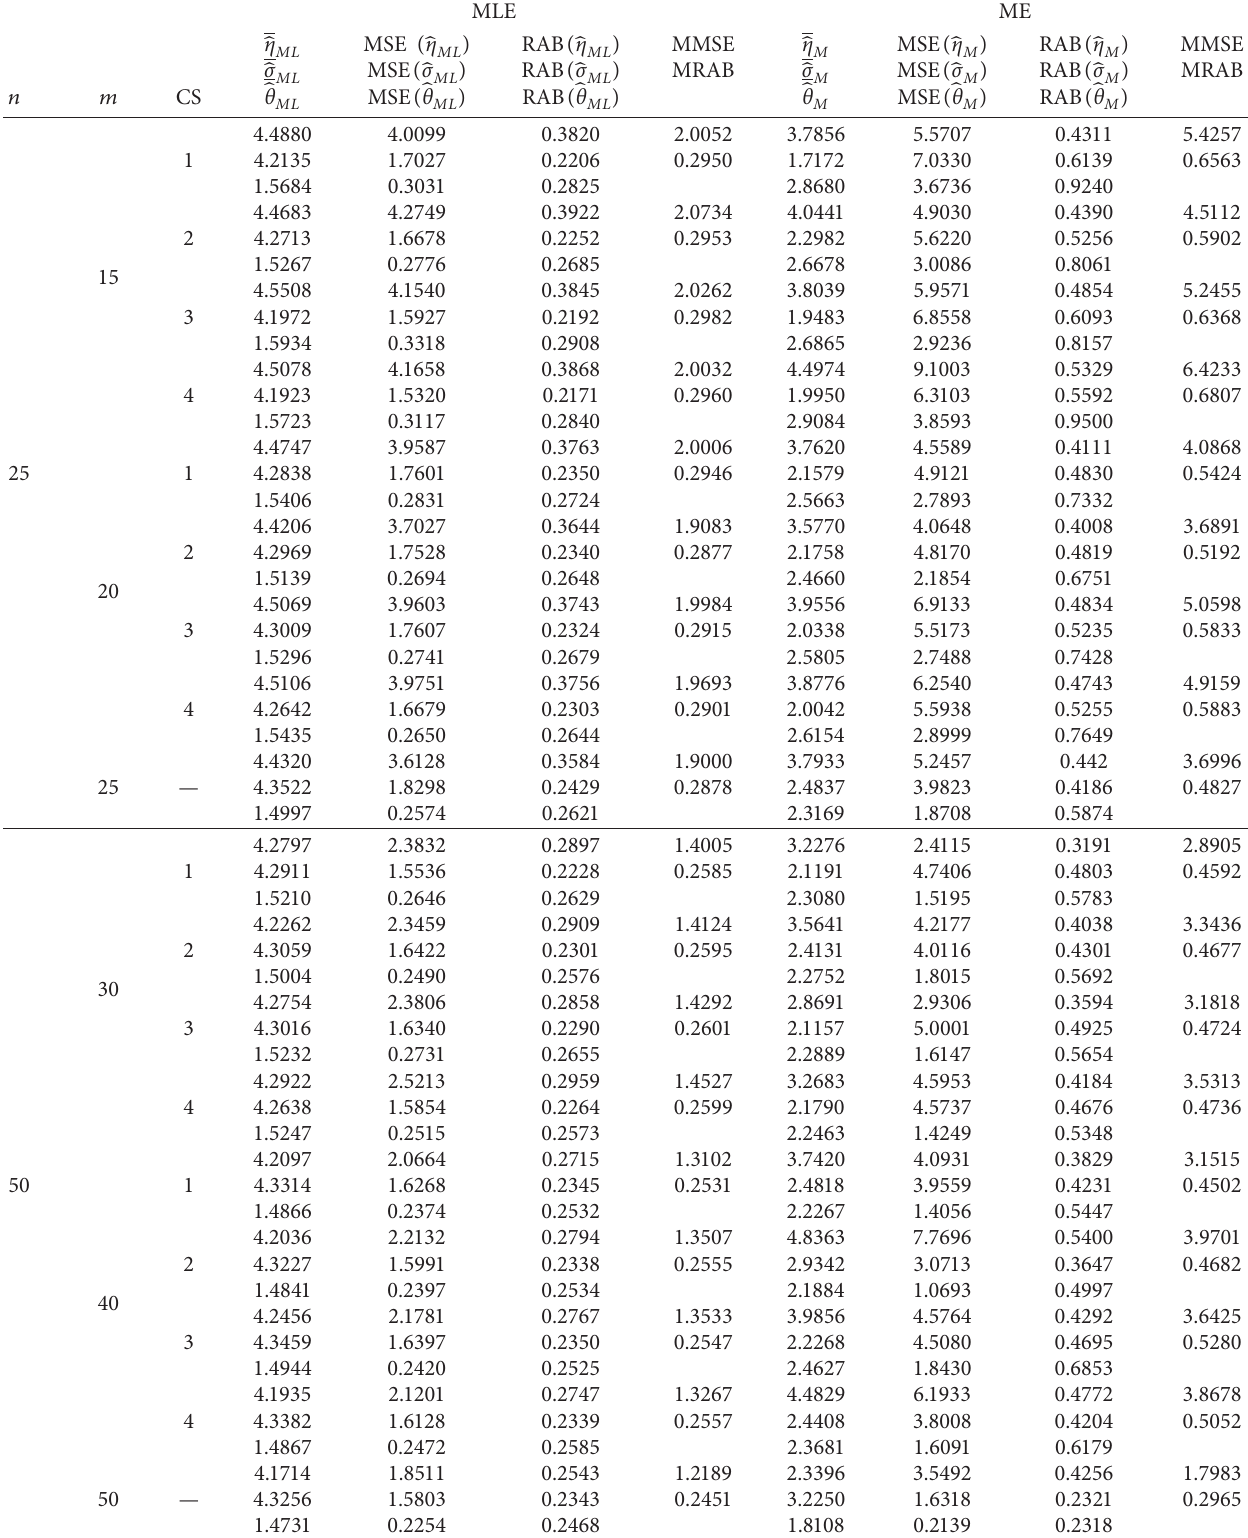
Table 4: ML and M estimates of η , σ , and θ with their MSEs, RABs, MMSE, and MRAB based on 5000 simulations. Population parameter values are η � 4 . 0, σ � 4 . 0, and θ � 1 .